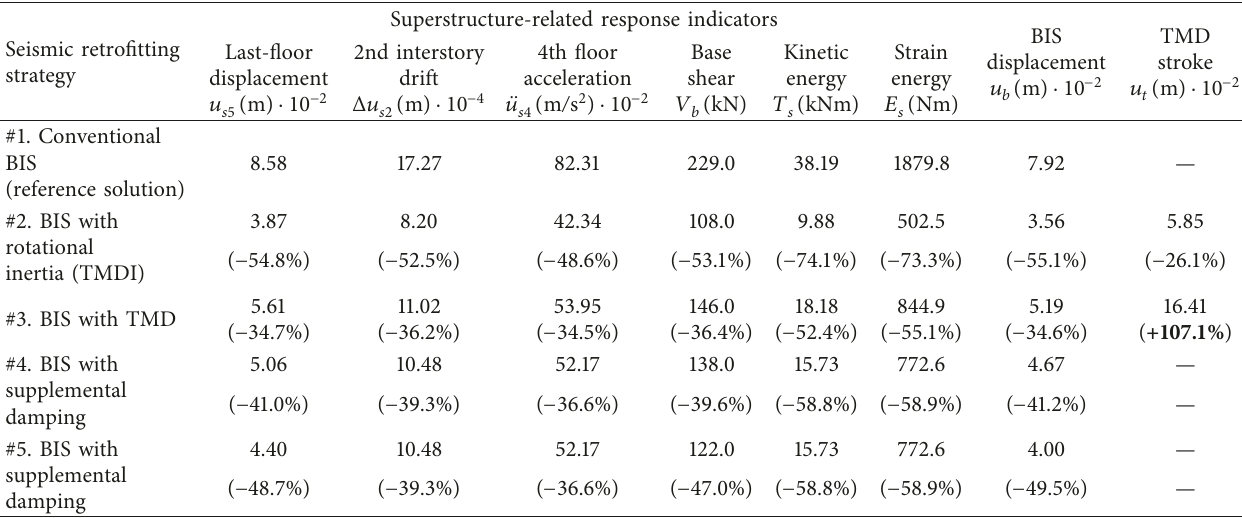
Table 3: List of results considering average RMS values of response indicators (Monte Carlo method with 100 artificial samples). Seismic retrofitting strategy